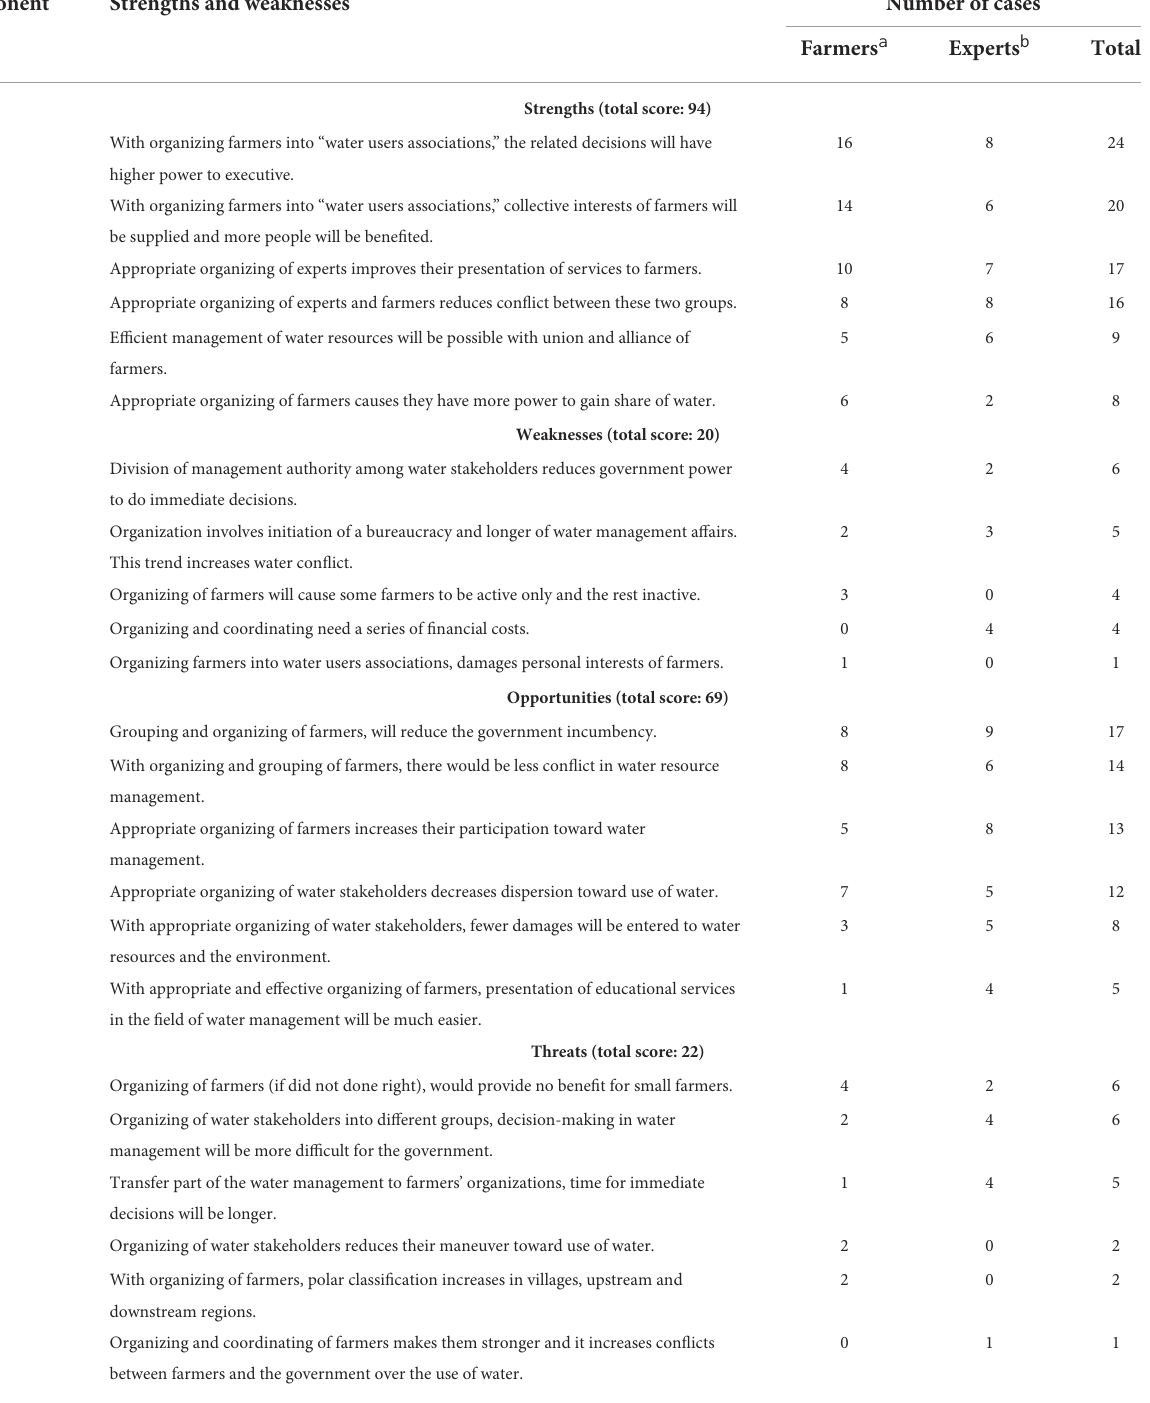
a Farmers:Measuringisdonebasedonthespectrumfromnobody(0)toalloffarmers(20). b